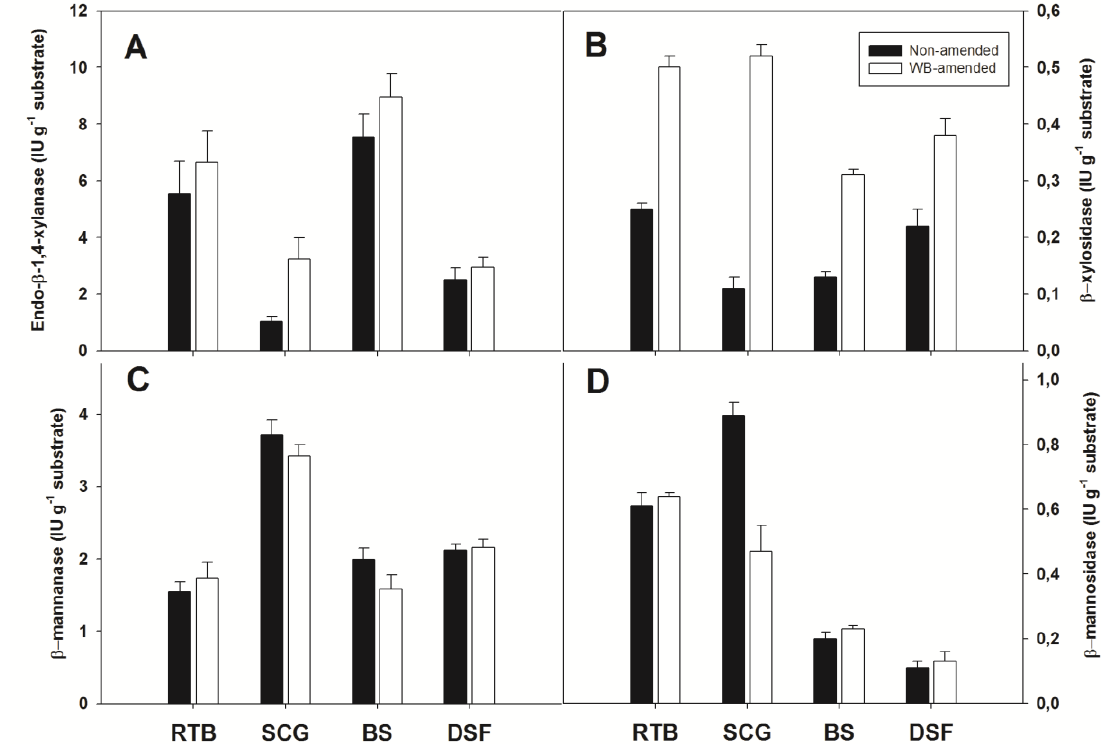
Figure 2. Specific activities, referred to unit mass of initial substrate, of endo- β -1,4-xylanase ( A ), β -xylosidase ( B ), β -mannanase ( C ), and β -mannosidase ( D ) in 14-day-old solid-state cultures conducted on residual thistle biomass (RTB), spent coffee grounds (SCG), barley straw (BS) and digestate solid fraction (DSF) in the presence and absence of wheat bran (WB) as the amendment. Data are the mean ± standard deviation of four replicates.